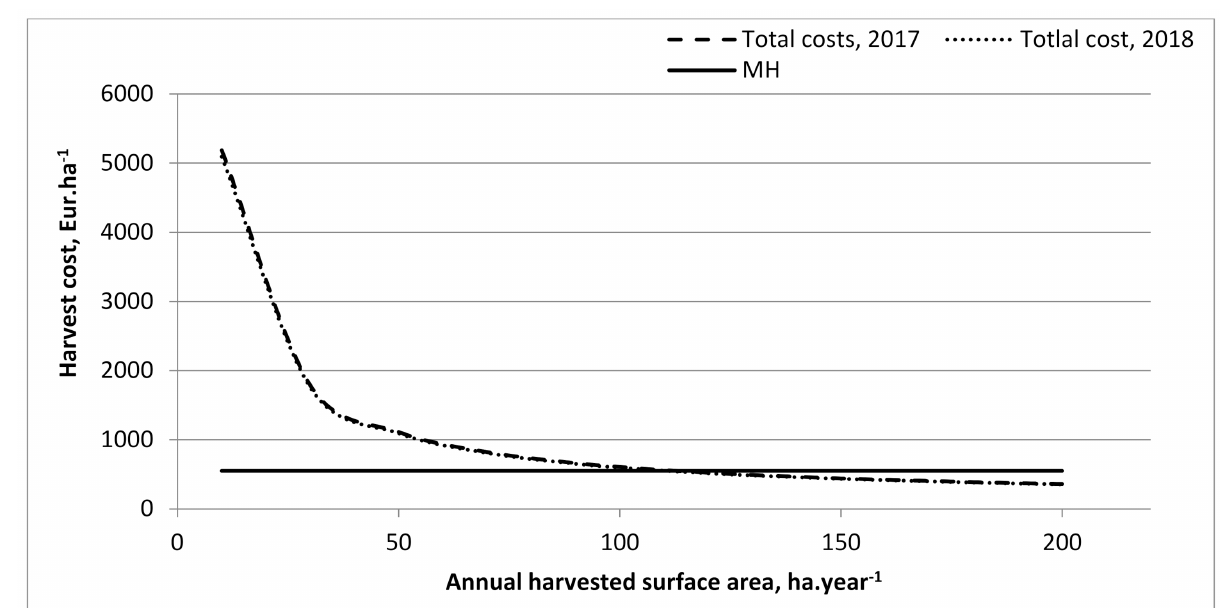
Figure 4. Harvesting costs with harvested area for total vineyards, year 2017 and 2018. MH: Manual